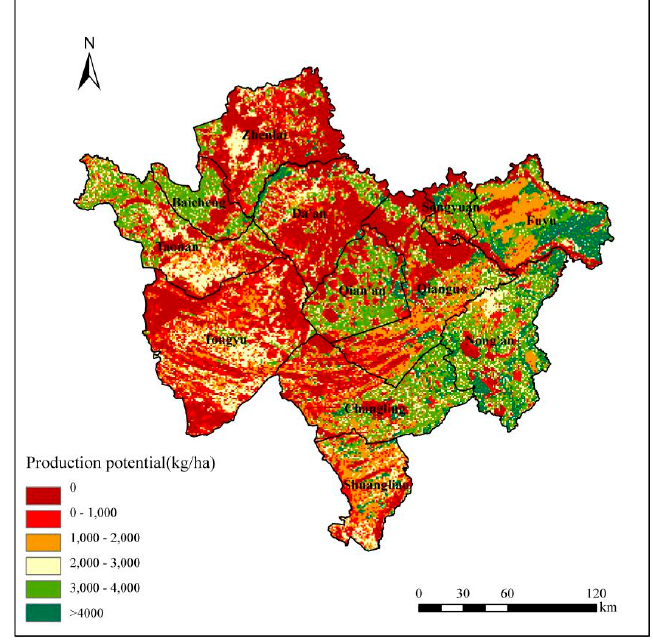
Figure 4. Spatial distribution of soybean production potential in 2013.